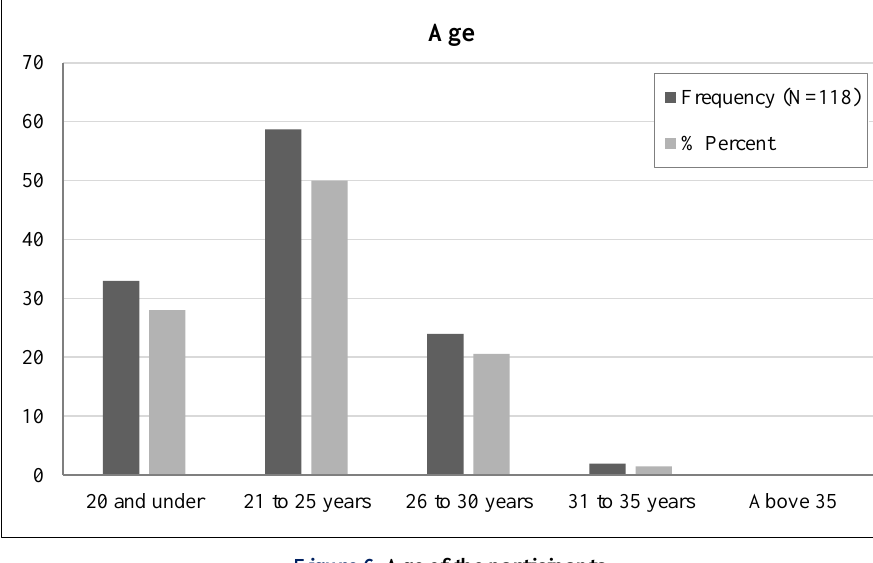
Figure 6. Age of the participants